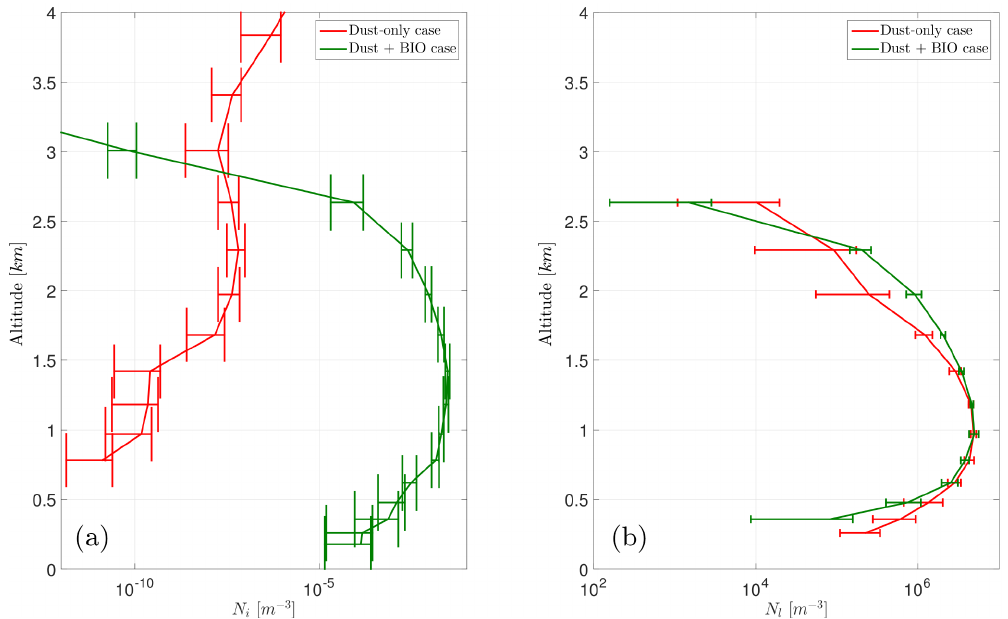
Figure 10. Vertical profile of the ice crystal number concentration ( a , N i ) and the cloud droplet number ( b , N l ) for the cases DST and BIO for an exemplary section over